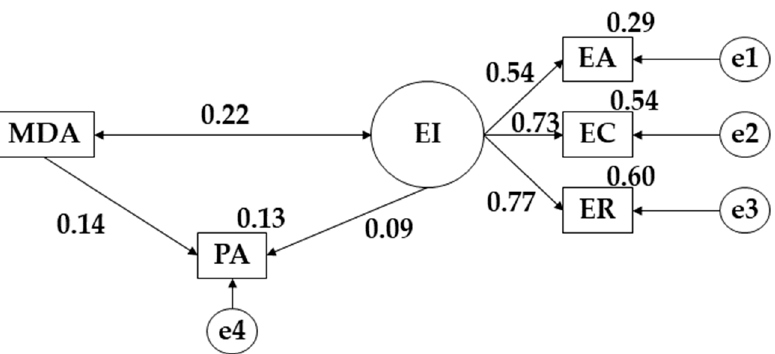
Figure 2. Model proposed for the entire sample. Note: emotional clarity (EC); emotional repair (ER); emotional attention (EA); Mediterranean Diet adherence (MDA); physical activity (PA). The proposed model's male population shows a good fit for each of its indicators. relationships are observed between emotional attention (EA) (r = 0.537), emotional clarity (EC) ( p ≤ 0.001; r = 0.735) and emotional repair (ER) ( p ≤ 0.05; r = 0.771) with respect to emo-